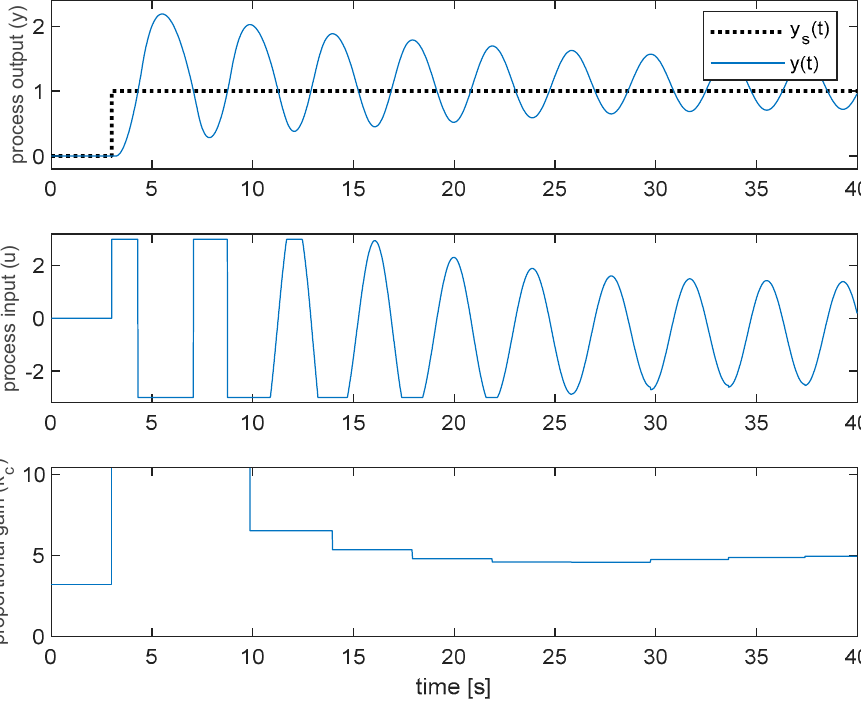
Figure 19. Response of the proposed method for the unstable process and PA set = − π .